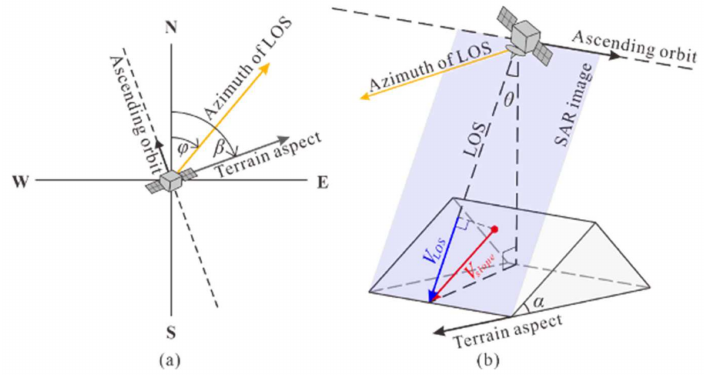
Figure 2. An imaging scenario with the satellite in ascending mode and the slope dipping away from the radar: ( a ) The azimuth angle of satellite LOS and terrain aspect; ( b ) The geometric relationship between satellite position and local